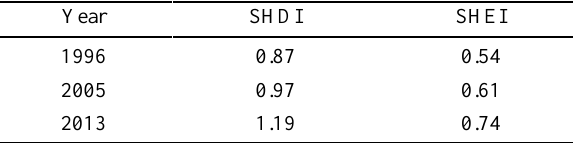
Table 8 Landscape diversity index of Hangzhou